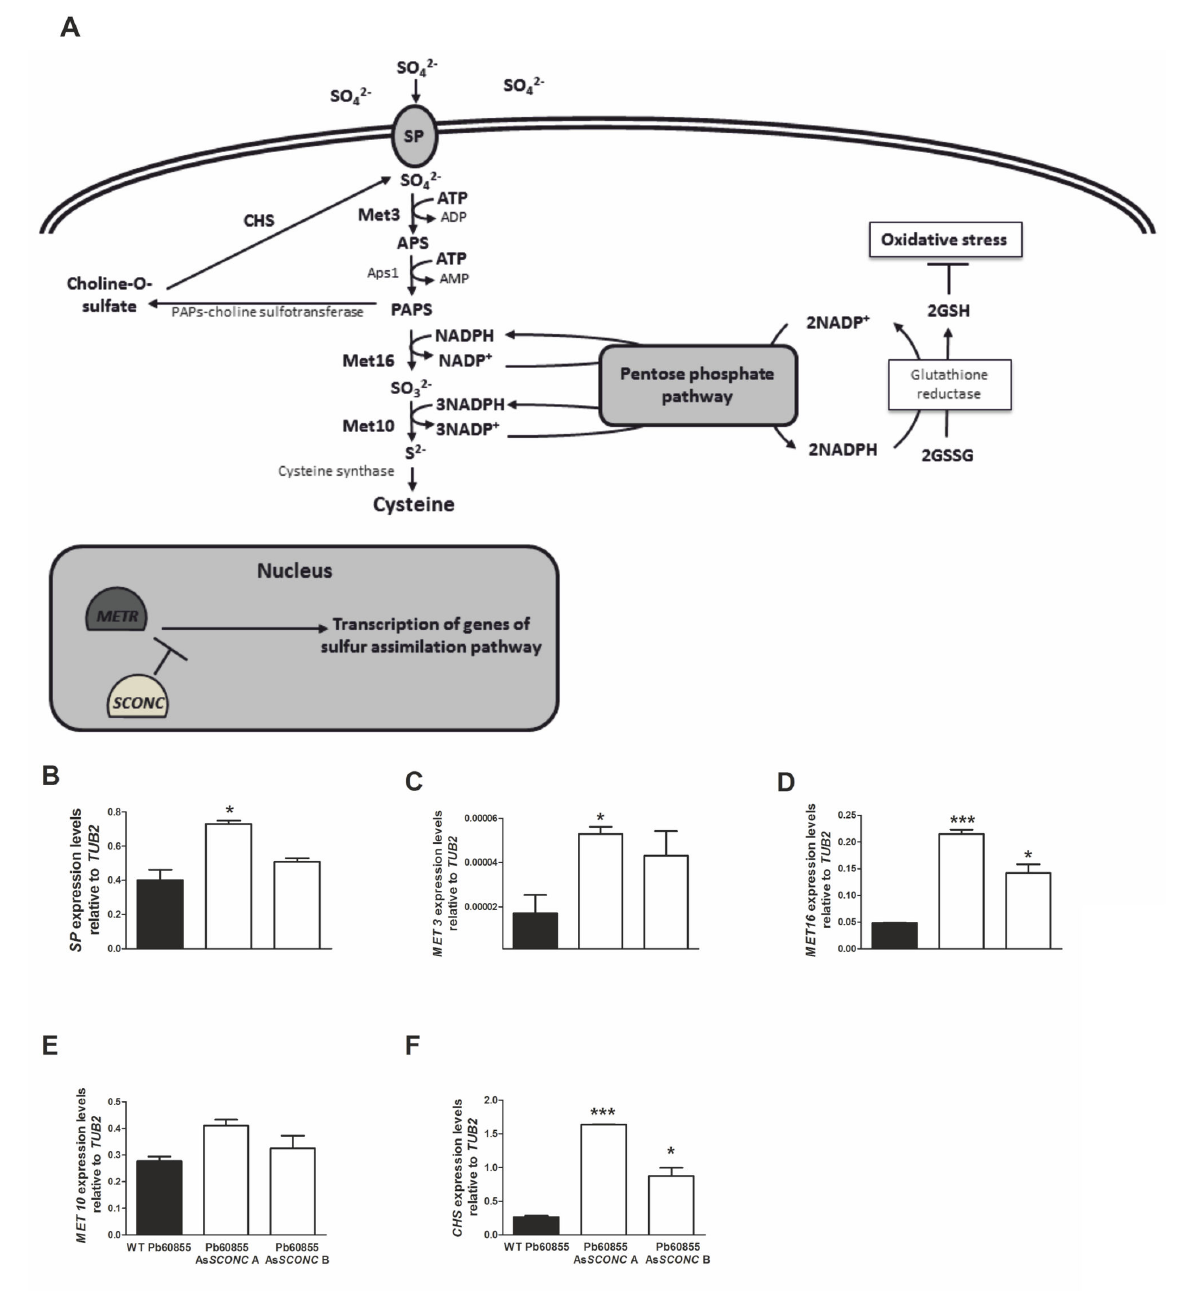
Figure 2. Sulfur assimilatory pathway and interplay with the glutathione system and pentose phosphate pathway. ( A ) SconCp orchestrates MetRp proteolysis, therefore resulting in the transcriptional repression of several genes from this pathway. The interplay between sulfur assimilatory pathway and the pentose phosphate pathway for the inter-conversion of NADP + and NADPH will impact on the levels of reduced glutathione (GSH), therefore on cells redox balance. ( B - F ) SCONC down-regulation results in increased expression levels of inorganic sulfur assimilation pathway related genes. Expression profiles of genes coding sulfate permease (SP), ATP sulfurylase (MET 3), PAPS reductase (MET 16), sulfite reductase (MET 10) and choline-O sulfatase (CHS) in wild-type strain Pb60855 and two down-regulated clones, Pb60855 As SCONC A and Pb60855 As SCONC B grown to the exponential phase in complete MMvM (MMvM +Cys/+SO 42- ) at 37°C. Asterisks represent statistical differences between wild-type strain and aRNA clones (*p<0.05; ***p<0.001). SCONC expression levels determined by qRT-PCR were normalized to expression of the internal reference gene β-tubulin (TUB2). Bars represent means and standard deviations. doi: 10.1371/journal.pone.0074725.g002 PLOS ONE |